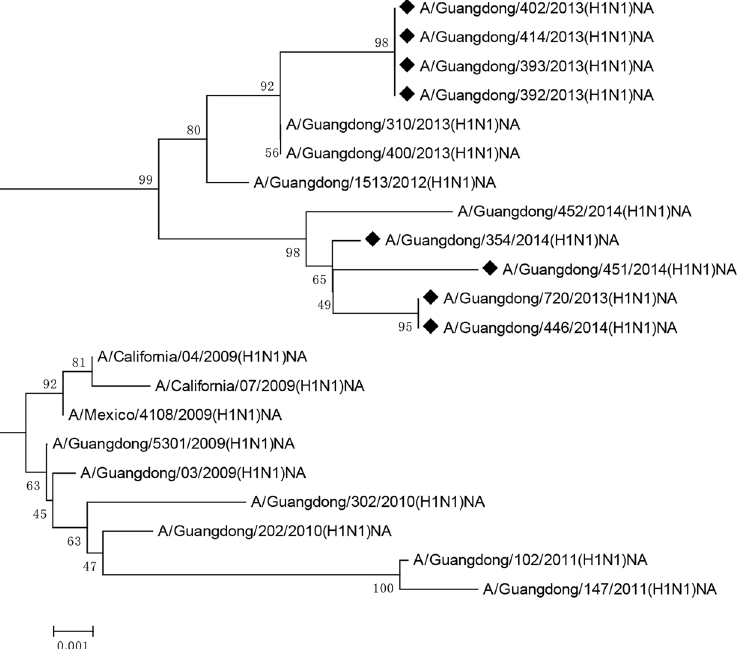
Figure 2. Phylogenetic analysis of NA sequences of influenza A(H1N1)pdm2009 oseltamivir-resistant strains from Guangdong,